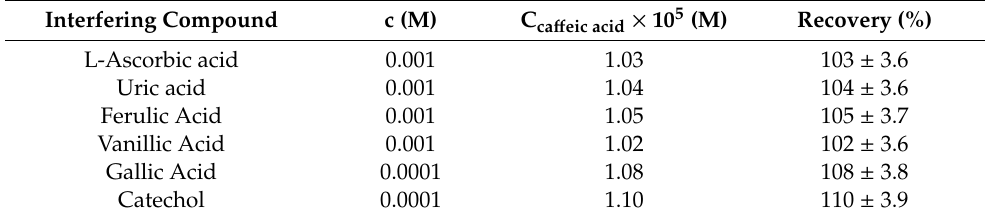
Table 9. The interference of some chemically related species on the quantitative determination of 10 − 5 M ca ff eic